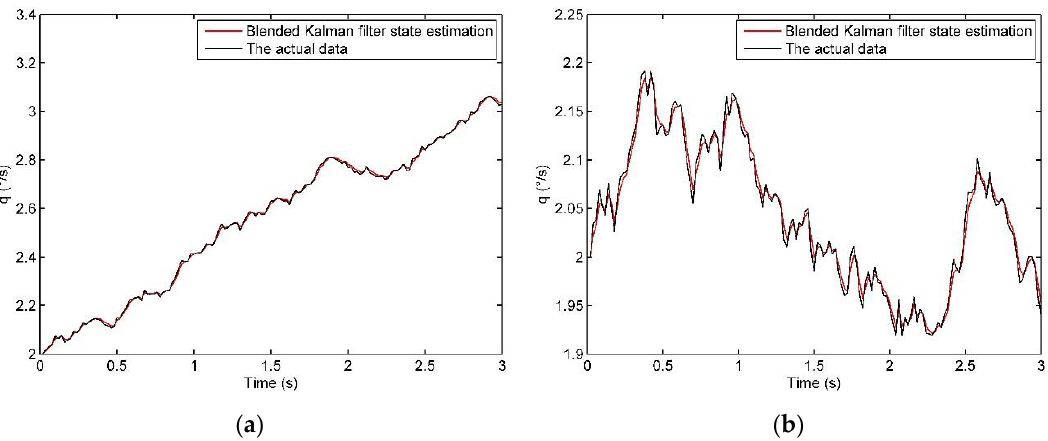
Figure 8. Type B fault vs. fault-free state estimation: ( a ) type B fault state estimation; ( b ) type B fault-free state estimation.